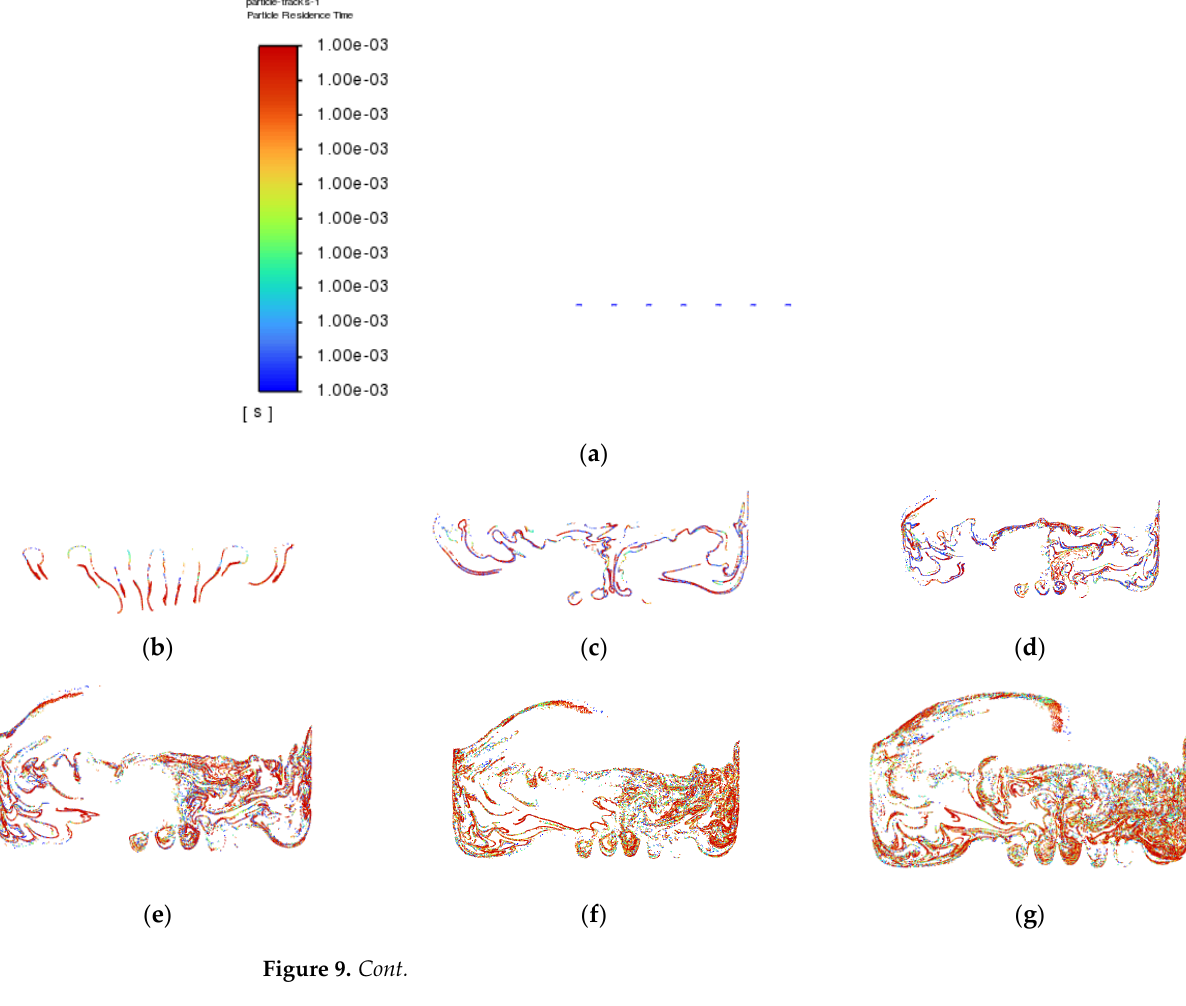
Figure 8. Histogram of particles at the outlet of Simulation 2. *Units of diameter in m. The purpose of showing Figure 8 is to confirm that there were actually injected par- ticles escaping from the outlet of the atomisation chamber successfully. Figure 9 shows the pathway flow of the injected particles.